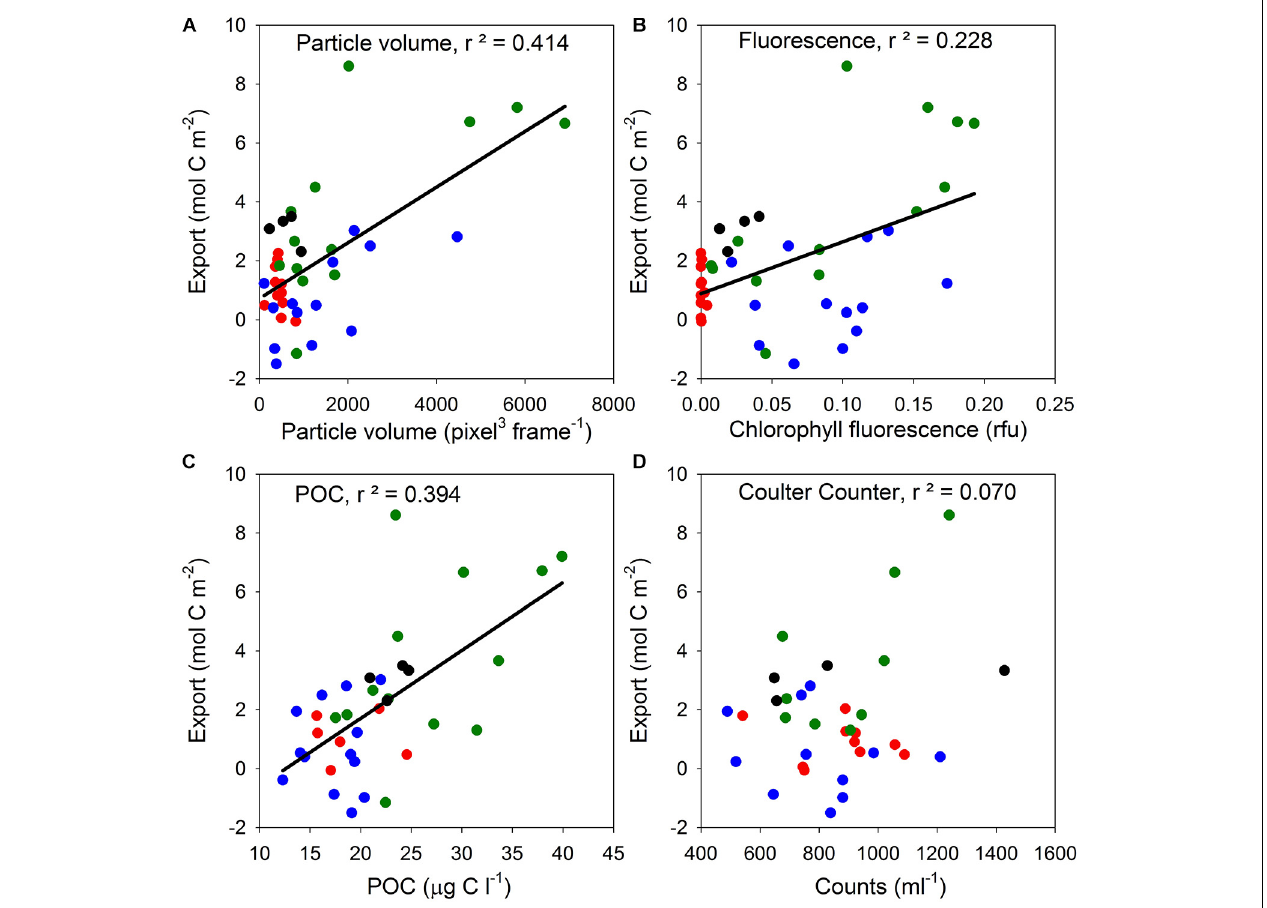
FIGURE 4 | Seasonal export of carbon, as determined by upper water column carbon mass balance in the Ross Sea (DeJong et al., 2017), compared with mean water column particle concentrations between 200 and 300 m indicated by four different methods. (A) Total particle volume per frame determined by the video particle profiler. (B) Fluorescence measurements using a Wetlabs Fluorometer. (C) POC determined from Niskin bottle samples. (D) Coulter Counter counts for particles in the size range from 3 to 10 µ m. Color codes of data points: red, south site; green, Terra Nova Bay; blue, north site; black, transect stations across the central Ross Sea (see Figure 1 for